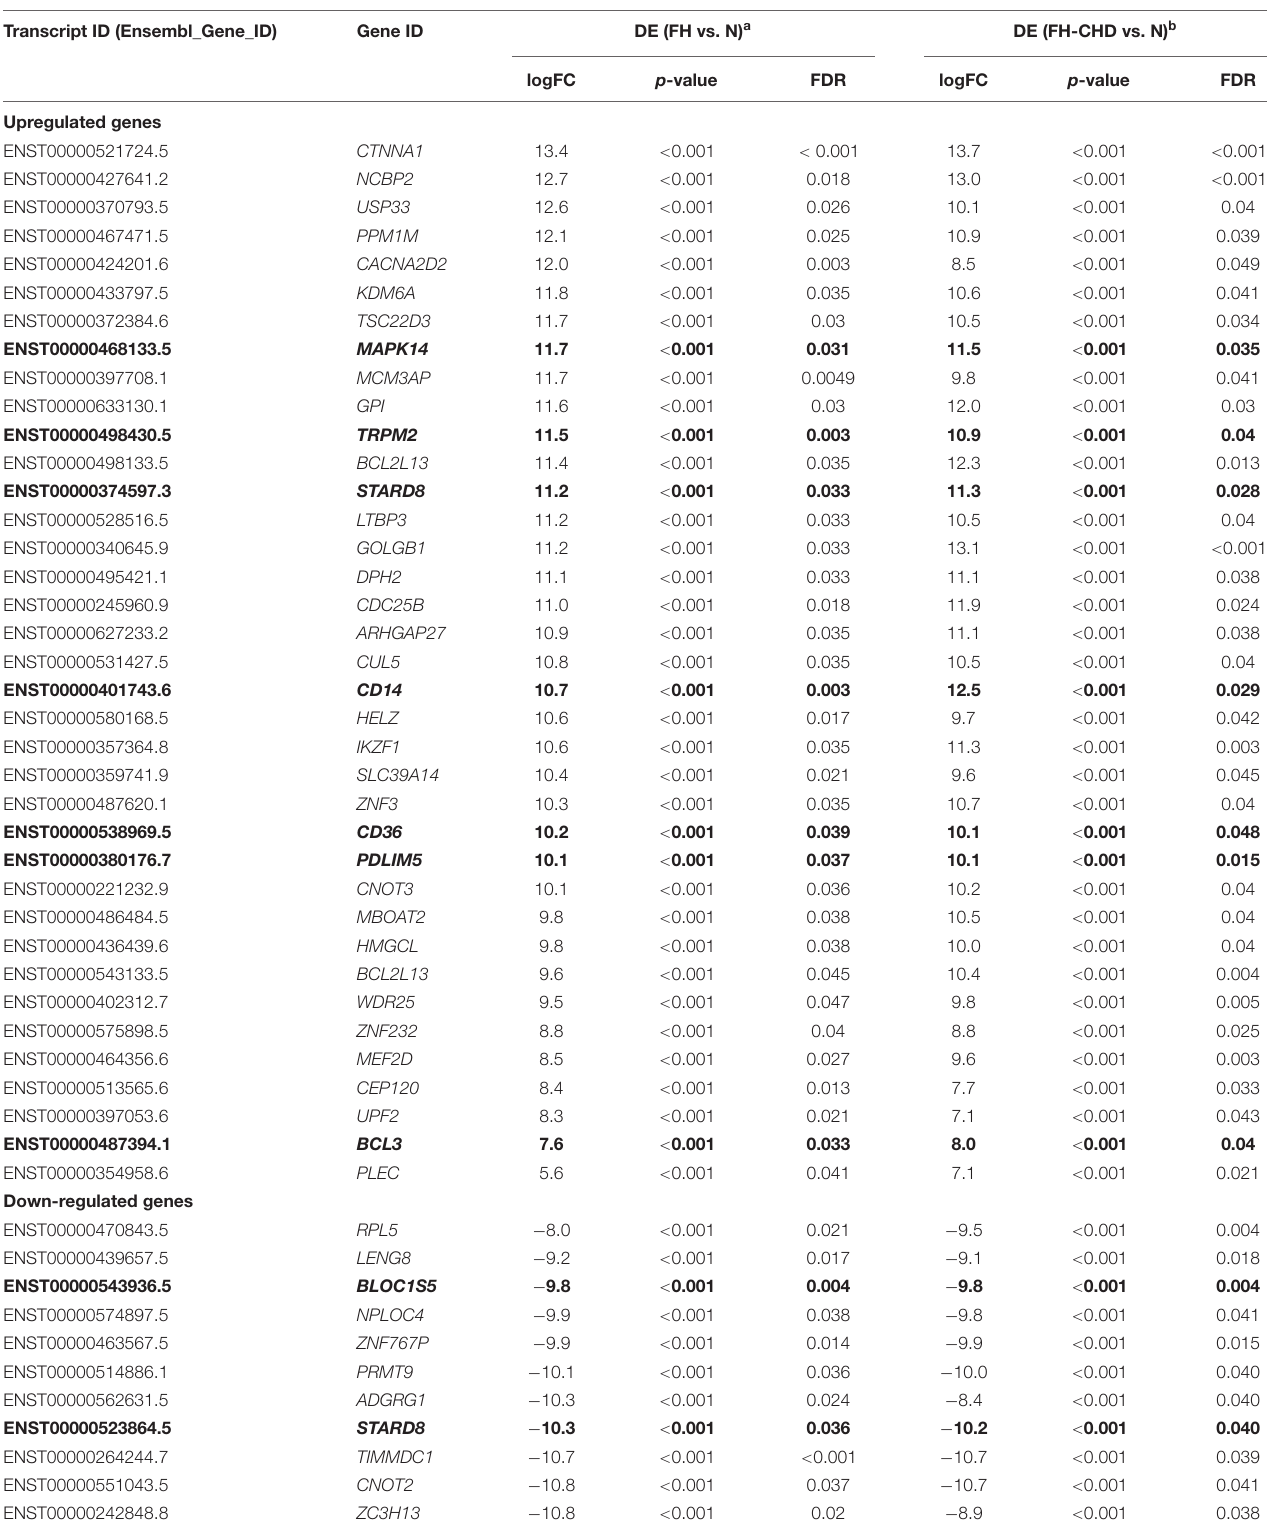
TABLE 1 | Fifty-five intersecting genes expressed in patients in the FH and FH-CHD groups but not in the N, H, and CHD groups, including 37 significantly up-regulated and 18 down-regulated